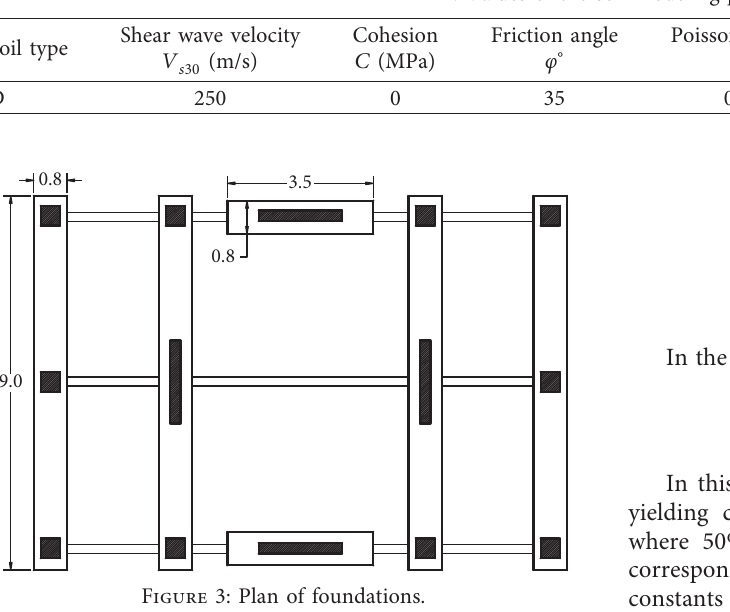
Table 2: Values of the soil modeling parameters.